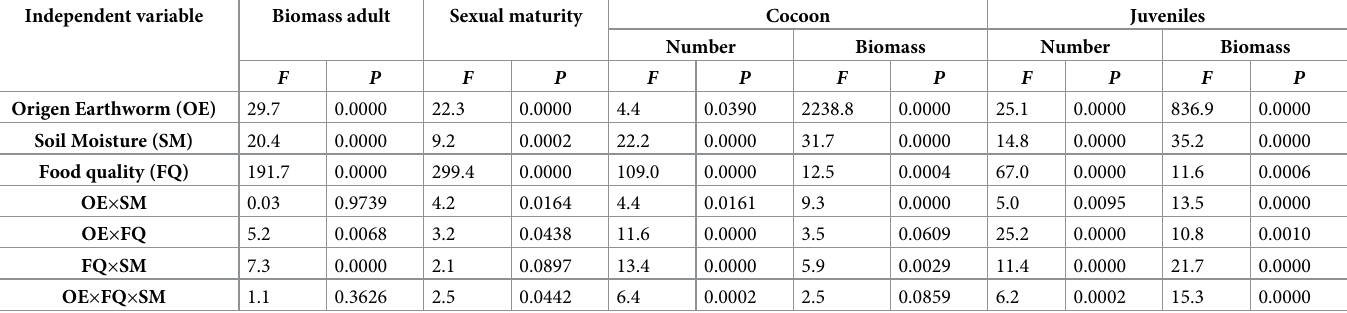
Table 1. F -values and significance levels (ANOVA) of the interaction of three factors on growth and reproduction of the tropical endogeic earthworm Pontoscolex corethrurus and Balanteodrilus pearsei at 100 days of culture in soil with low anthropic